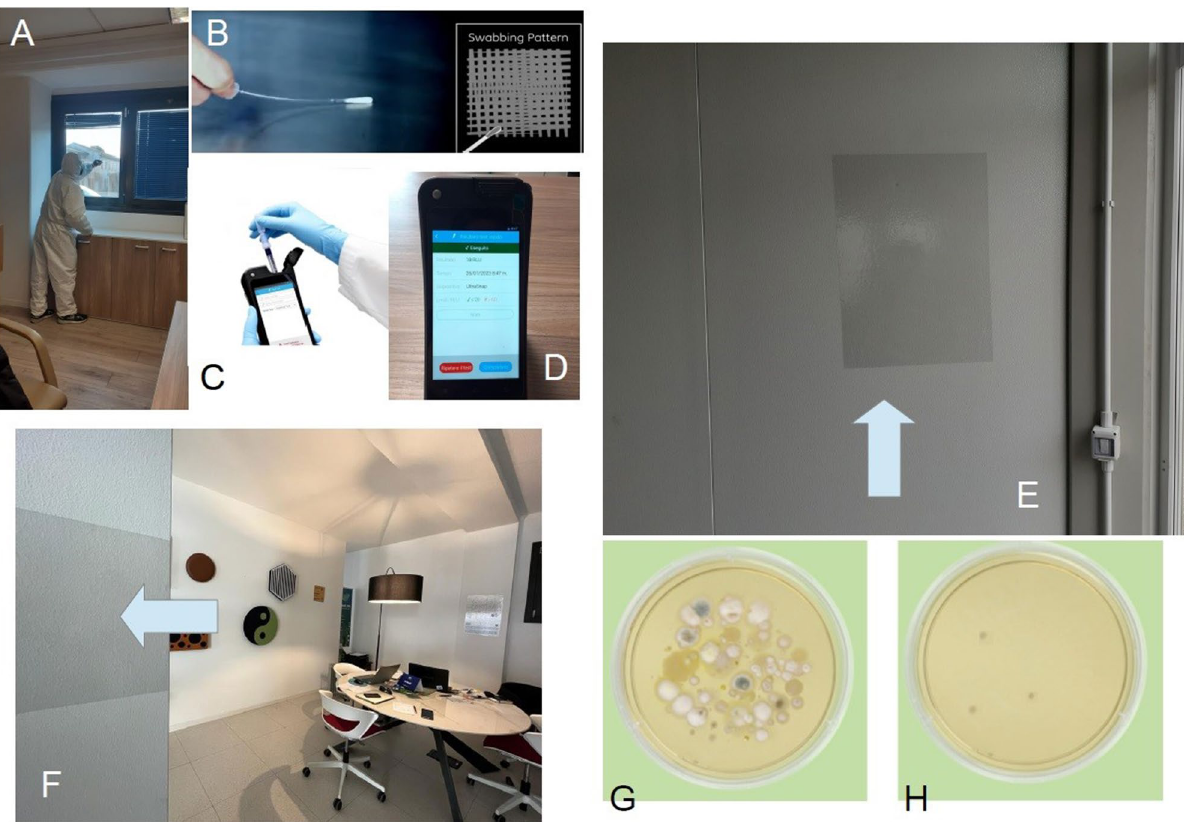
Figure 1. Brief summary of the process of swab test for RLU performance. ( A ) The co-author LB while swabbing on the inside part of a vertical surface (a window glass, for example), ( B ) Way by which the swab must be handled and used on the surface; ( C ) Inserting the swab in the RLU detection device; ( D ) an example of RLU read out; ( E ) and ( F ) Different examples of the WIWELL TiO 2 –Ag–NP application (a job container and an office); ( G ) Microbiology output on a TSA plate (37 °C, 48 h) before and ( H ) after the application for 12 h of the WIWELL TiO 2 –Ag–NP adhesive